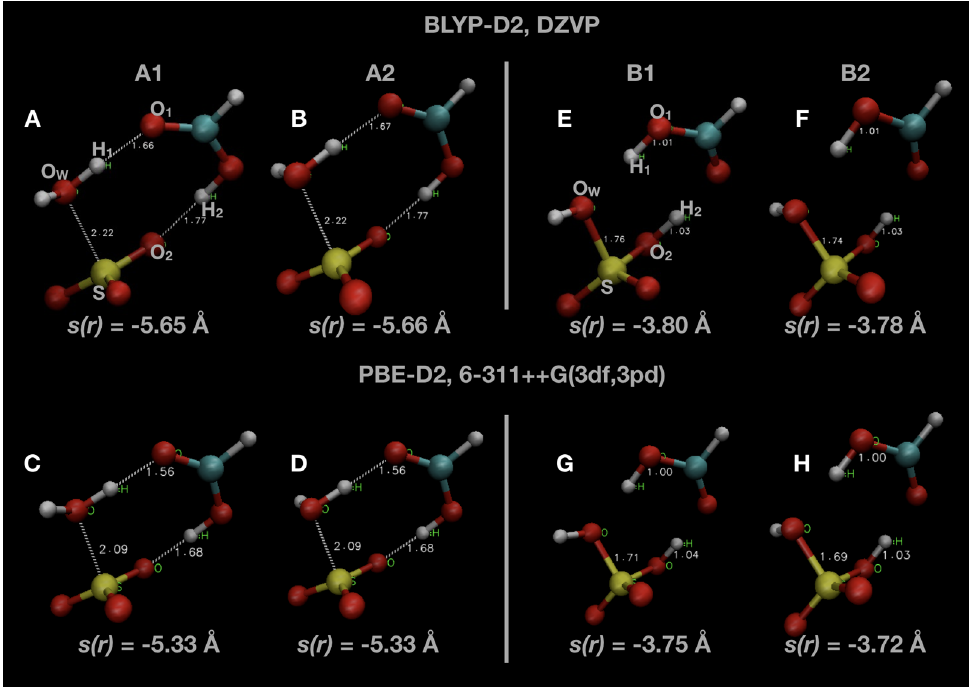
Figure 1 Snapshots of optimised initial states (A – D) and fi nal product states (E – H) of the system. Indicated atoms and inter-atomic distances are used in the de fi nition of the order parameter s ( r ) de fi ned in Eq.